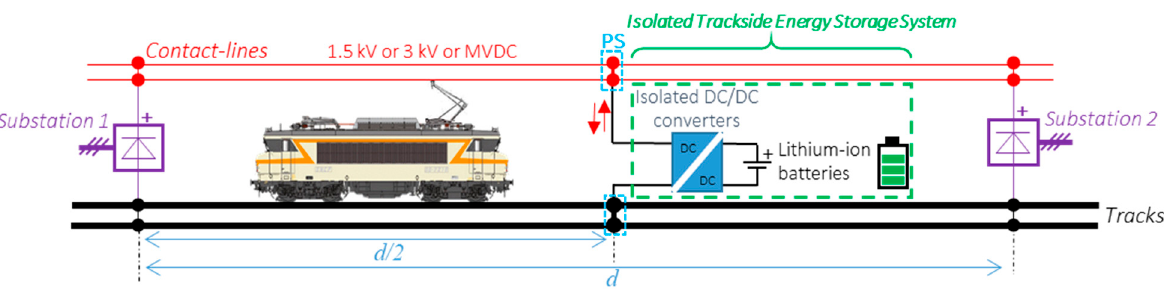
Figure 1. Principle of reinforcement of a DC railway line sector with isolated trackside energy storage system (TESS) installed in the middle of the sector (at d/2) at the paralleling station (PS).